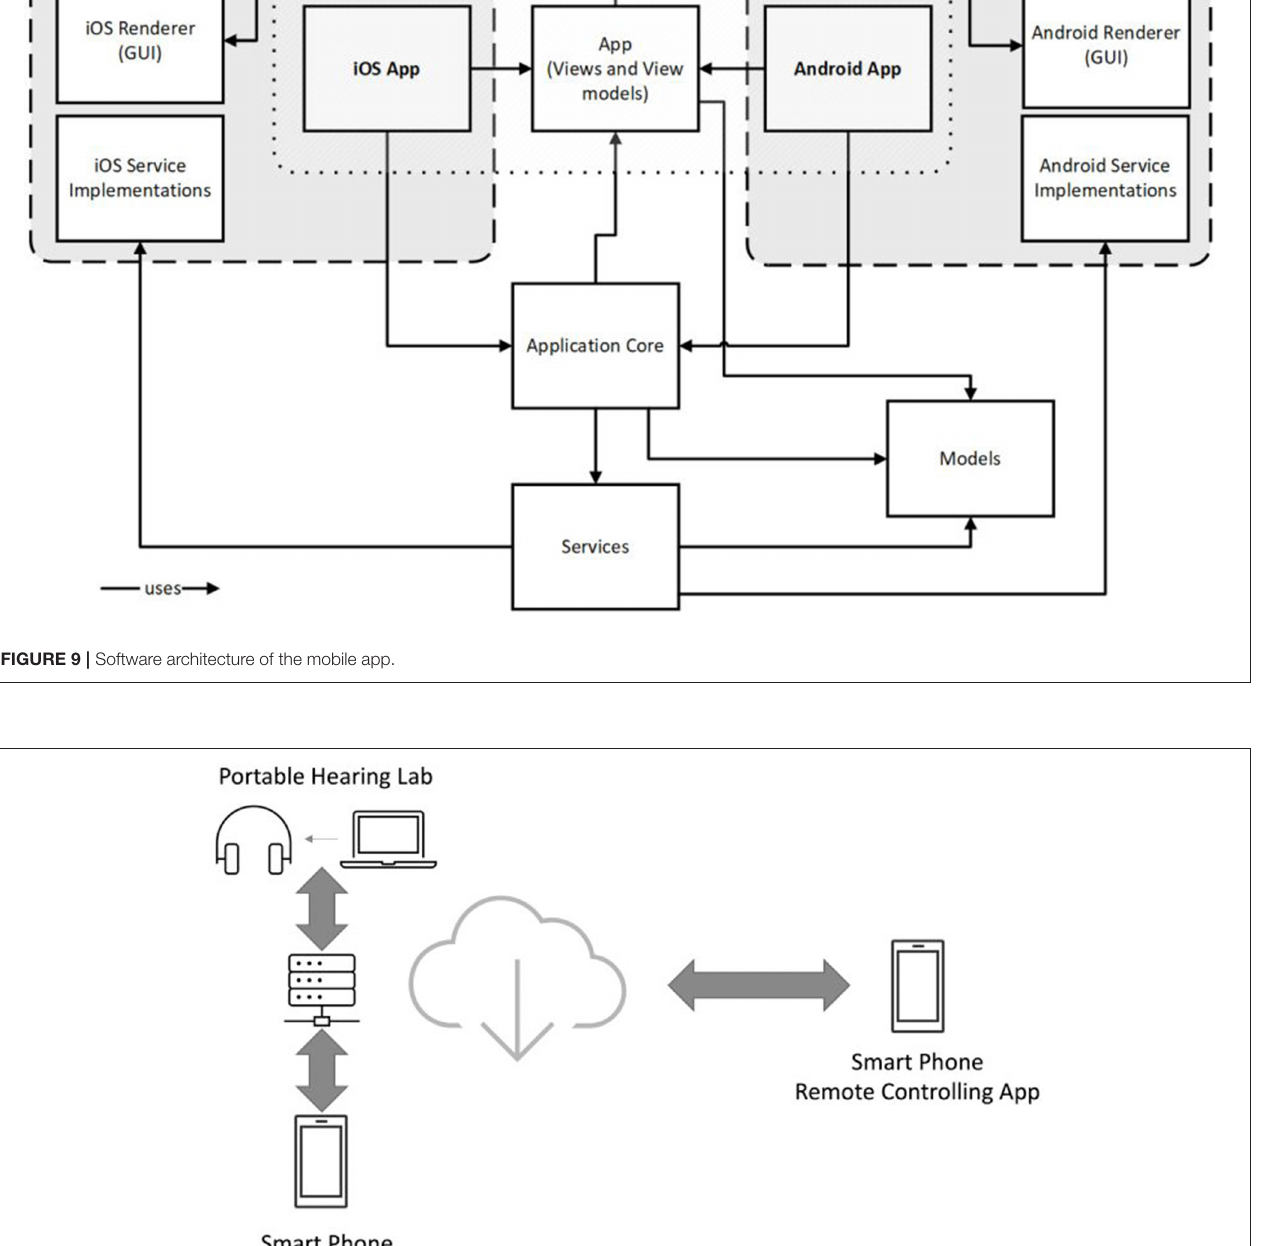
Frontiers in Digital Health |